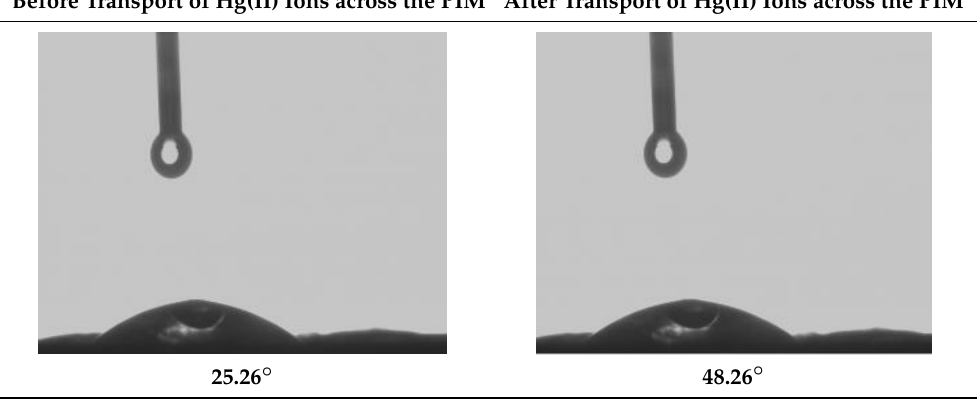
Table 2. The appearance of a water drop on the membrane and the contact angles of the polymer matrices before and after the transport of Hg(II) ions across PIM. Source phase: 1.0 × 10 −6 M Hg(II);